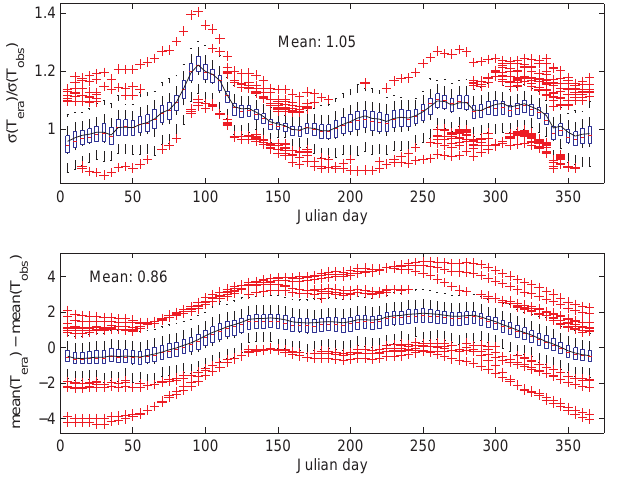
Fig. 11. Top: boxplot for the ratios of the ERA15/REMO standard deviations over the observed standard deviations. Bottom: boxplot for the differences between the ERA15/REMO average tempera- tures and observed average temperatures. Boxplots are shown for each block of 5 days, where each box represents the spread between all sub-basins. Area-weighted averages for each block of 5 days are represented with the solid black line. Median values are represented with the horizontal red lines while outliers are indicated with the red crosses and are calculated as values larger than 1.5 times the interquartile range.